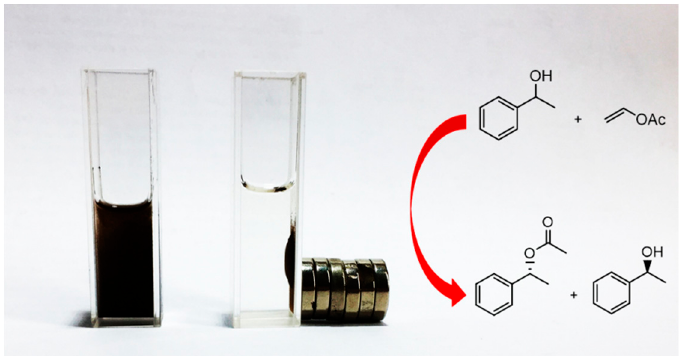
Figure 4. Schematic of the easy magnetic separation of magnetic CALB CLEAs.